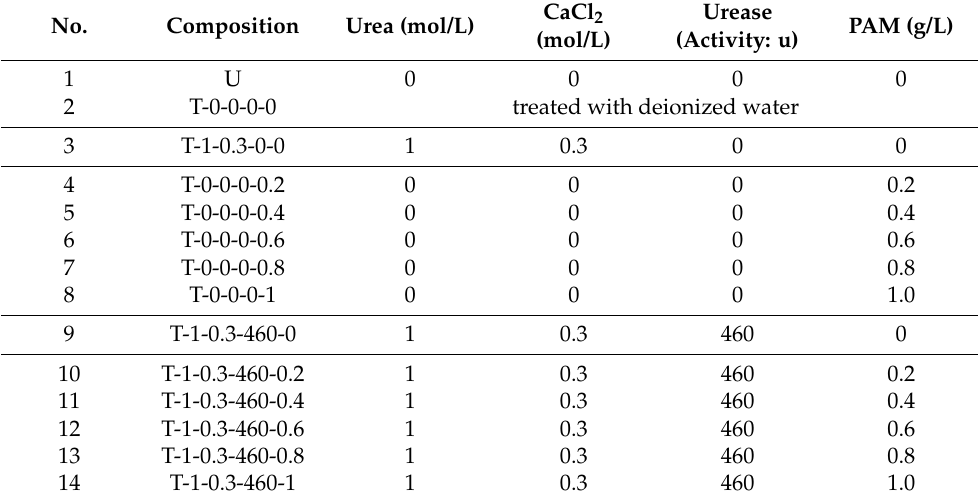
Table 2. Composition of different treatment